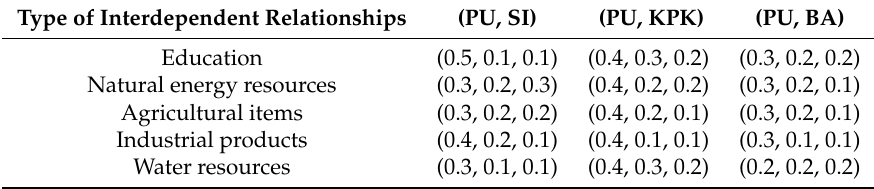
Table 2. IN set of interdependent relations between Punjab and other provinces. Type of Interdependent Relationships